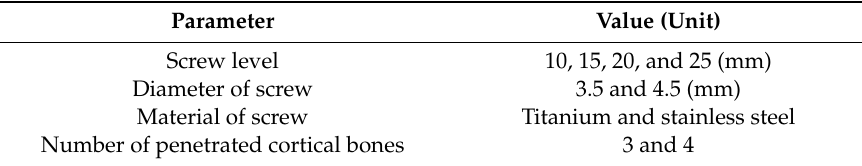
Table 1. Specifications of the finite element model.